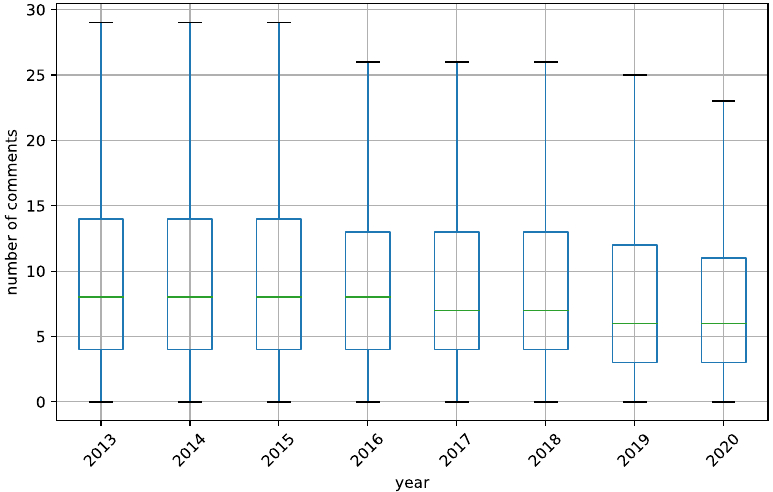
Figure A5. Distribution of the number of comments per year (outliers are omied).